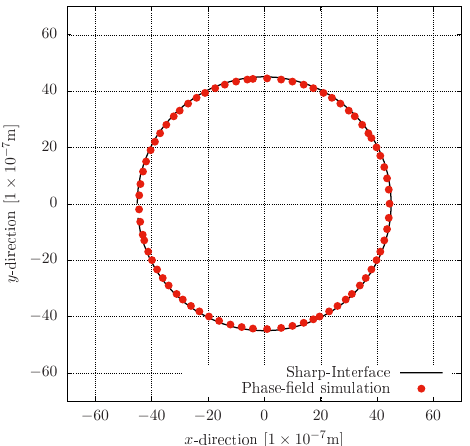
Figure 9. For an energetically isotropic interface δ αβ = 0, the simulated solid phase with radius r 0 = 45 10 − 7 m shows a complete agreement with the sharp-interface theory. Here, the obtained × = 0.0001 shows negligible effect from the underlying lattice on our simulated effective anisotropy δ e αβ crystal shape.